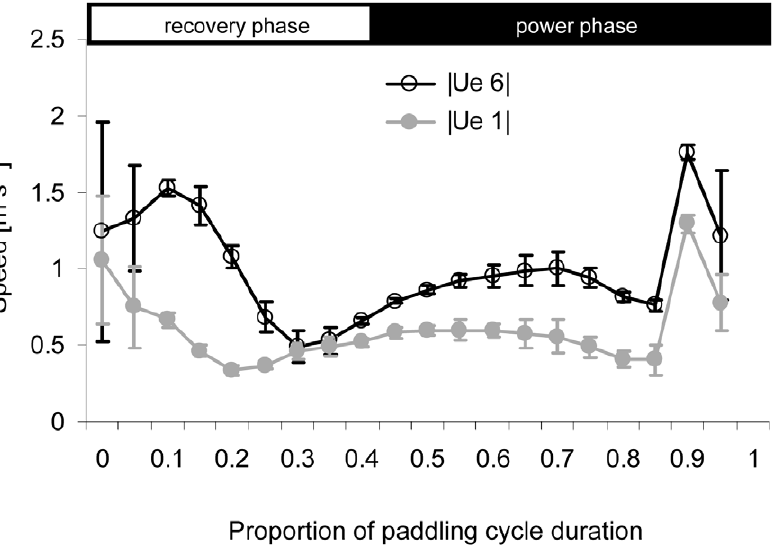
Figure 5. Speed of the foot relative to water. Shown are the root-mean-square speed of the proximal (e1) and distal (e6) foot elements during the paddling cycle. The horizontal axis is the same as in Fig. 4. The horizontal white and black rectangles at the top illustrate the division of the paddling cycle into the power and recovery phases. Data averaged from N=4 birds, 6 SD.